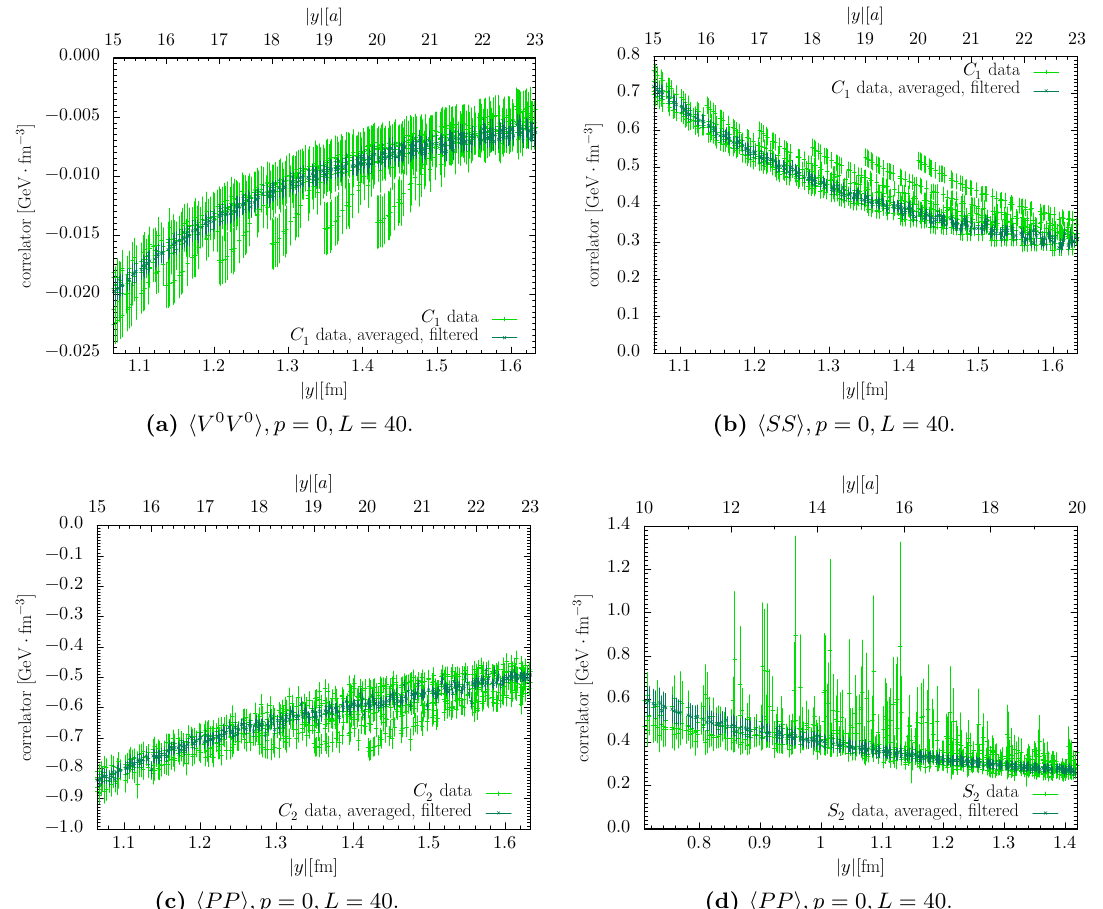
Figure 6. Anisotropy e(cid:11)ects in our data at large and intermediate y (light points) and their removal by the cut (4.2) (dark